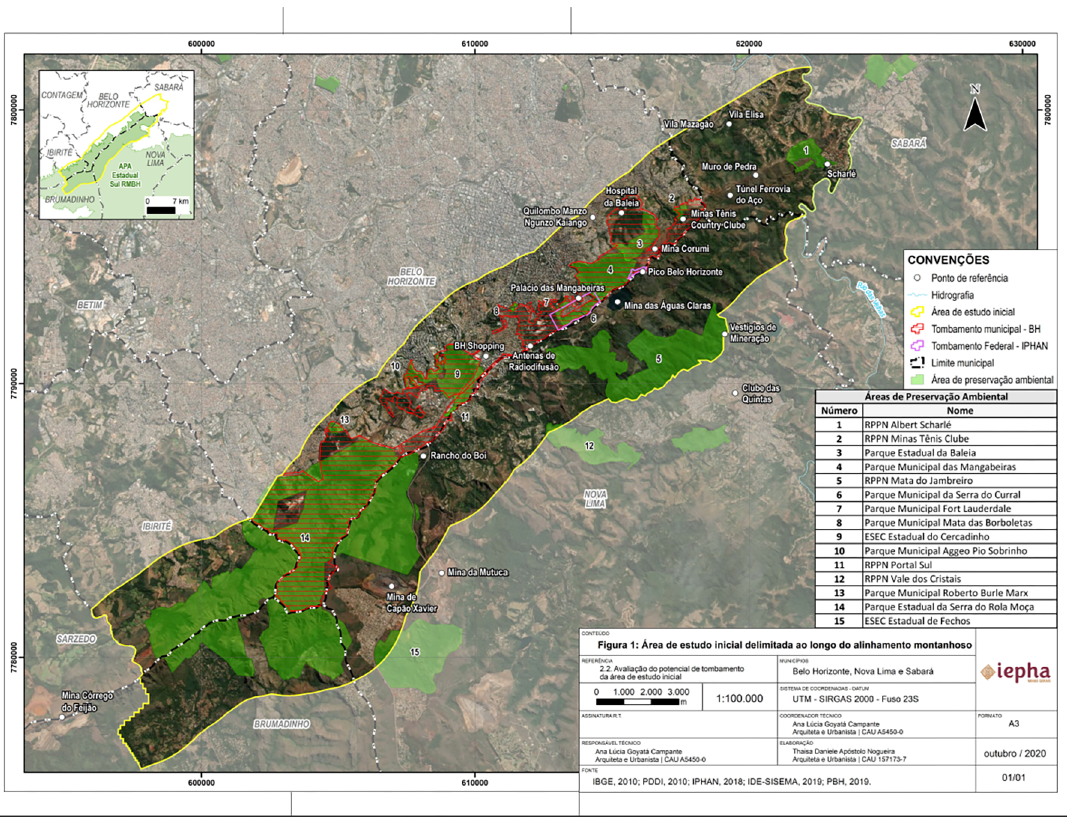
Figure 1. Serra do Curral